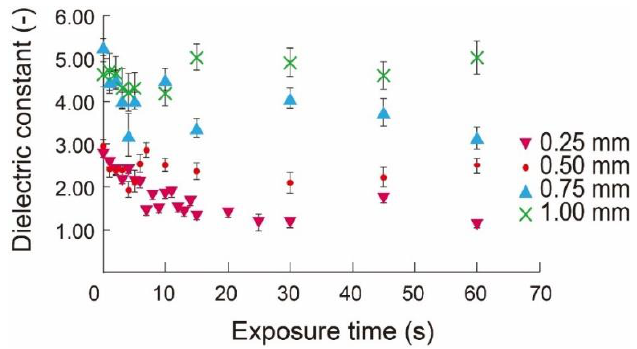
Figure 7. Dielectric constant of PDMS layers with respect to UV treatment time (n = 20).